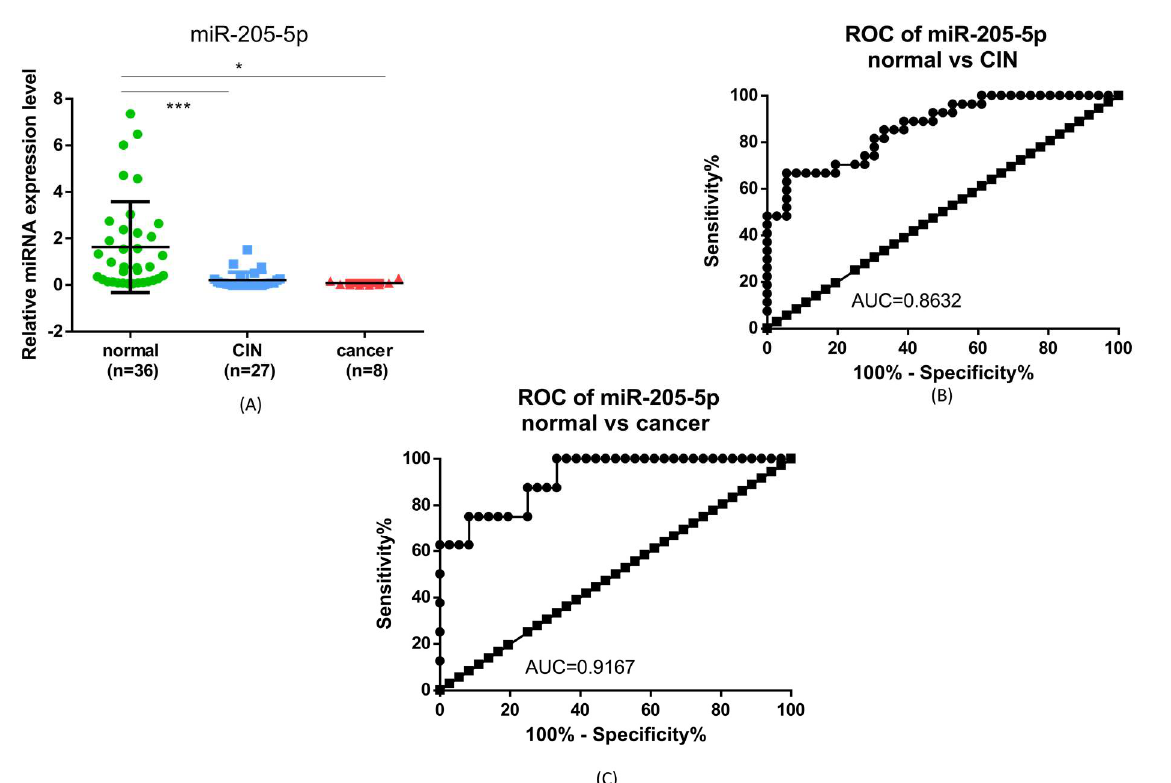
Figure 6. ( A ) Expression of miR-205-5p in selected samples; ( B ) ROC curve for miR-205-5p in normal vs. CIN samples; ( C ) ROC curves for miR-205-5p in normal vs. cancer samples. (* p ≤ 0.05, *** p ≤ 0.0001).